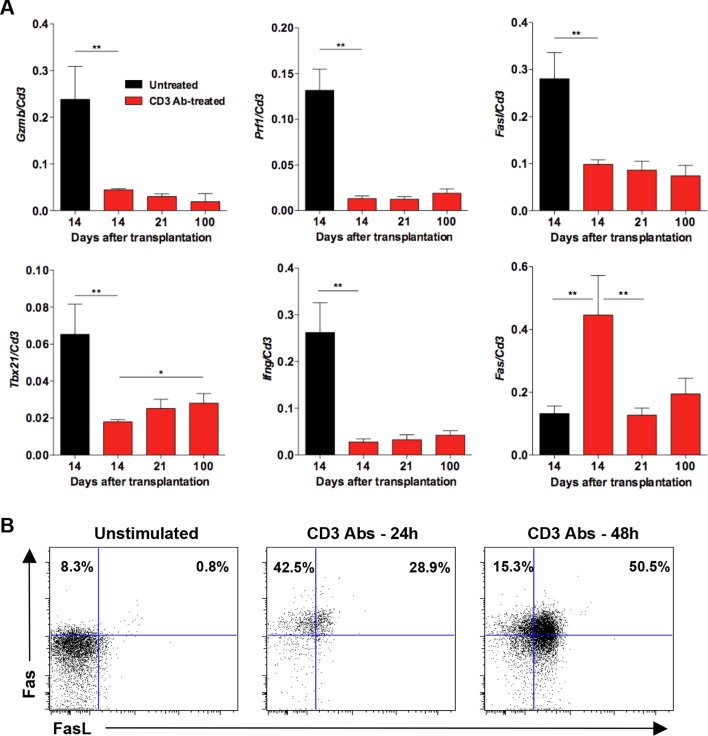
Expression of inflammatory, cytotoxic and apoptotic markers by CD8+ T cells.